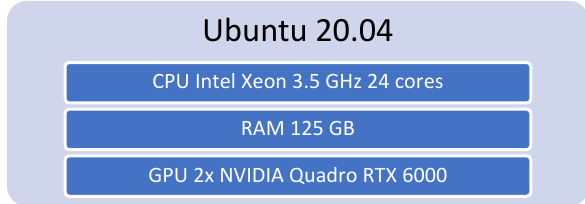
Figure 3. System architecture.